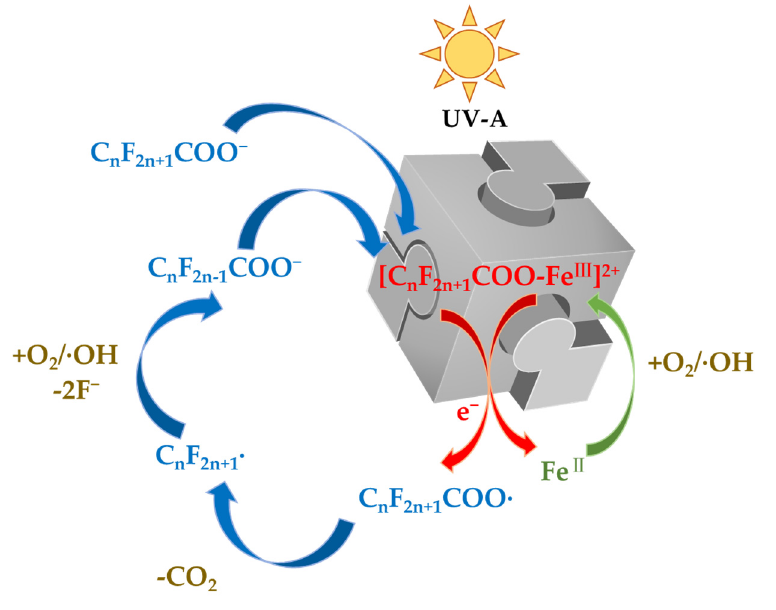
Figure 3. Photochemical mechanism of degradation of PFOA by UV − A irradiation on iron − doped zeolite. Reprinted with permission from Ref. [111]. 2020, Qian, L.; Georgi, A.; Gonzalez-Olmos, R.; Kopinke, F.-D.